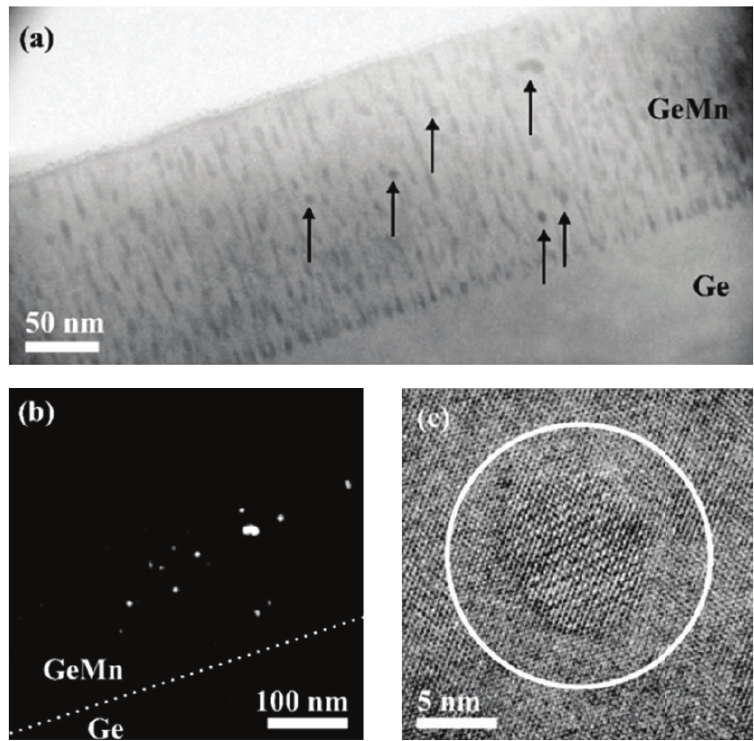
Figure 10: Cross-sectional TEM images of a sample with T S = 70 ◦ C. (a) Bright-field TEM image. Mn 5 Ge 3 precipitates are marked by arrows. (b) Dark-field TEM image recorded after selecting a characteristic reflex of the hexagonal Mn 5 Ge 3 lattice. Bright regions indicate Mn 5 Ge 3 precipitates. The dashed line is drawn to mark the interface between GeMn layer and Ge bu ff er layer. (c) High-resolution TEM of a typically coherent, hexagonal Mn 5 Ge 3 precipitate, circled by the white line. Reproduced from [15]. Copyright ©2006, The American Physical